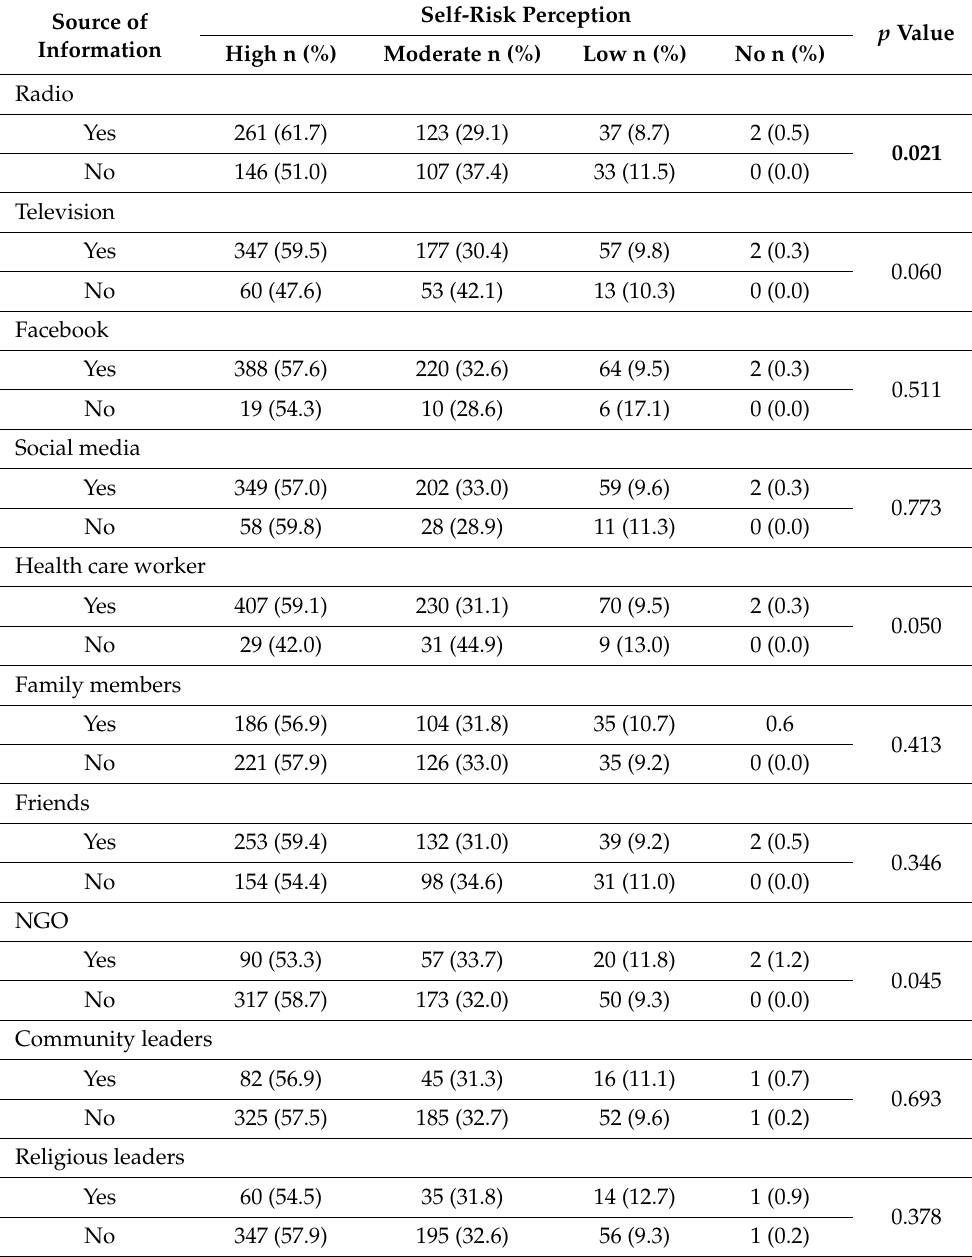
Table 1. Association between source of information and self-risk